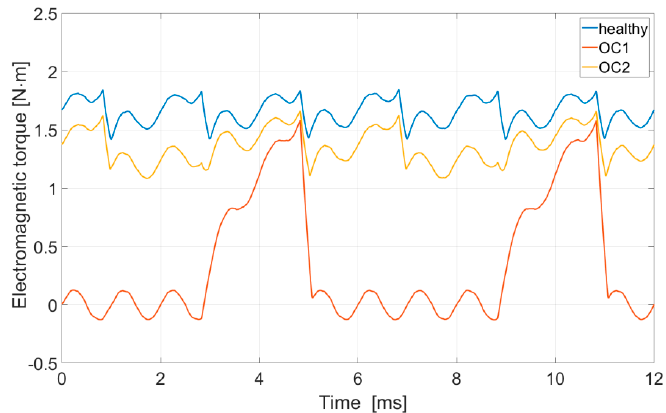
Figure 17. Star–delta (Y Δ ) configuration—waveforms of electromagnetic torque.